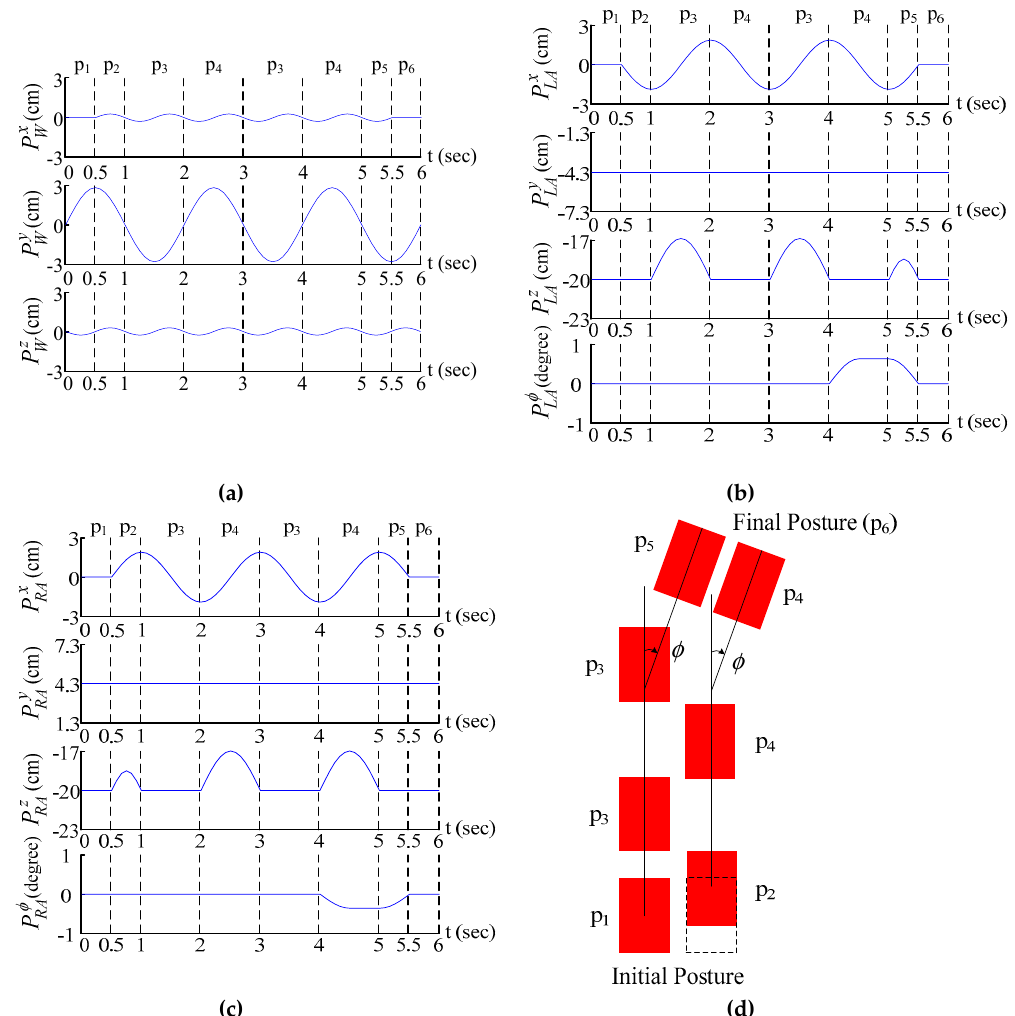
Figure 14. Trajectories and footprints with turning directions: ( a ) CoM trajectories; ( b ) left ankle